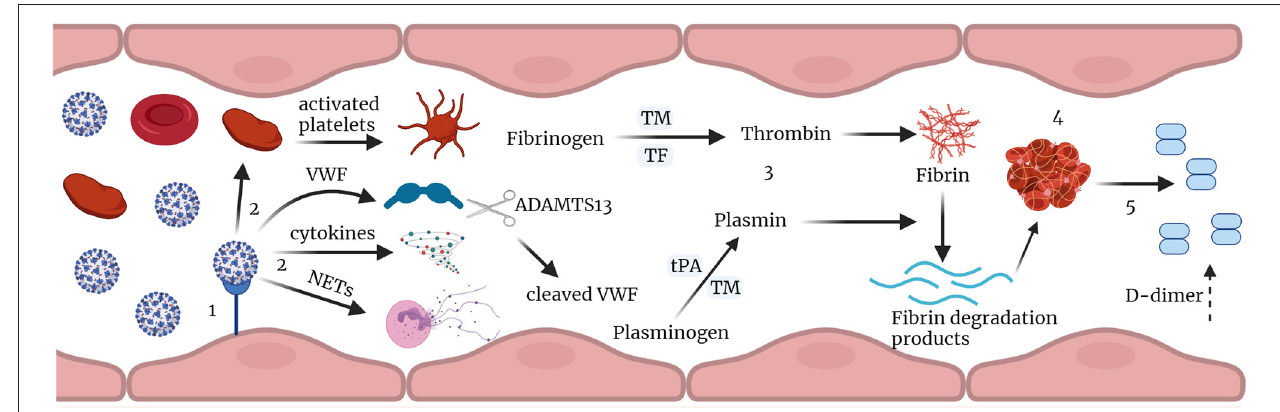
FIGURE 3 | Immune-thrombosis in COVID-19: endothelial and plasma coagulation: (1) Viral infection leading to endothelial damage and inflammation. (2) this leads to increased expression of cytokines, and procoagulant factors like VWF, activation of platelets and neutrophil extracellular traps (NETs) release; VWF is cleaved by ADAMTS13. (3) increased thrombin and plasmin generation potential in presence of thrombomodulin leading to increase in fibrin degradation products and D-dimer. (4) thrombus formation and (5) subsequent fibrin degradation that results in increased D-dimer in Covid-19. TM, thrombomodulin; tPA, tissue plasminogen activator; TF, tissue factor; VWF, von Willebrand factor; NETs, neutrophil extracellular traps (Figure created with